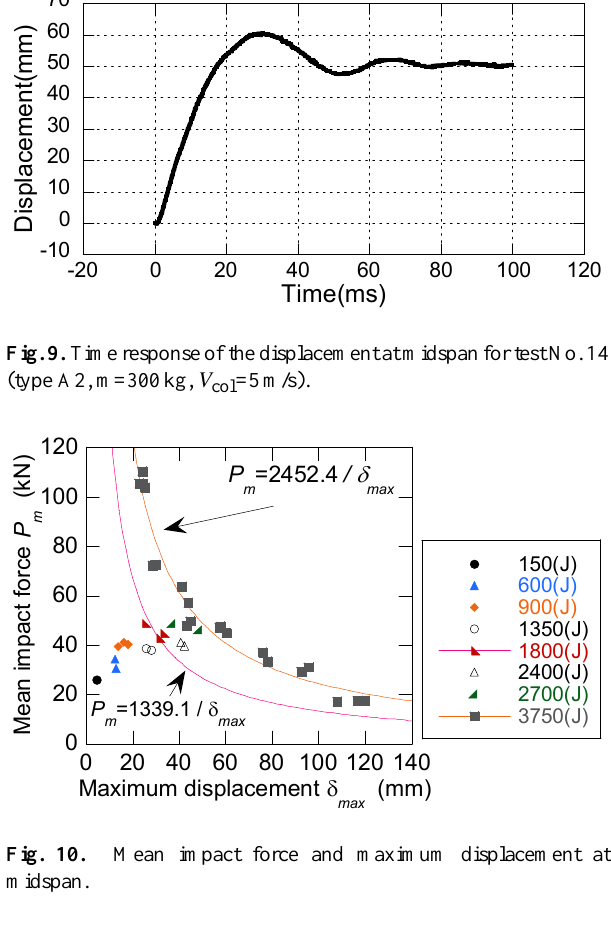
Figure 12. Time response of impact force for test No. 16 (type A4, m = 300 kg, V m =300kg, V col